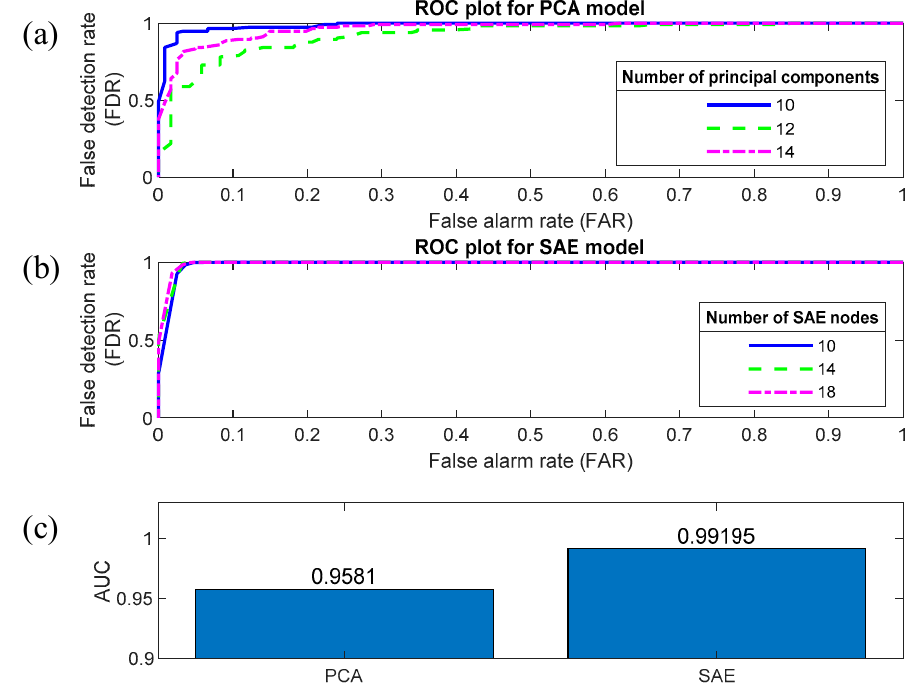
Figure 16. ROC curves and average AUC values for the detection of the bearing fault: ( a ) ROC curves for the PCA model with a different number of principal components; ( b ) ROC curves for the SAE model with different number nodes in the hidden layer; ( c ) average AUC values of the PCA and SAE models.